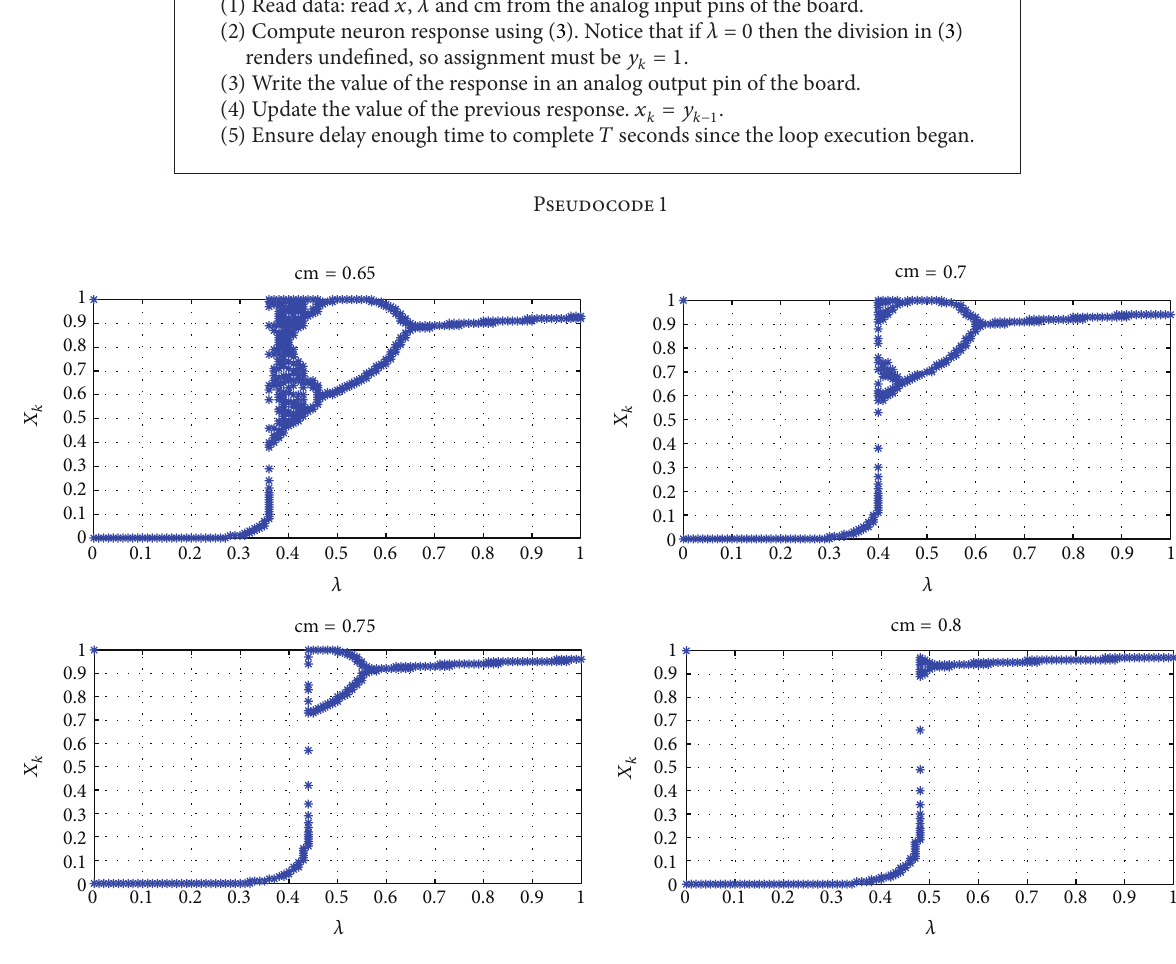
Figure 13: Bifurcation diagram using cm = 0.65, 0.70, 0.75, and